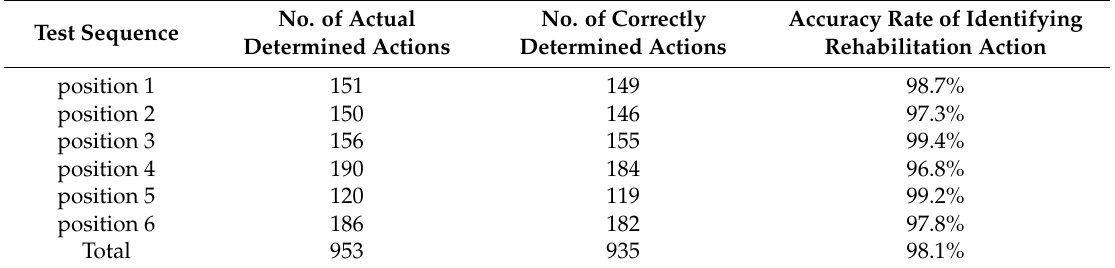
Table 5. Accuracy of identification of rehabilitation actions.